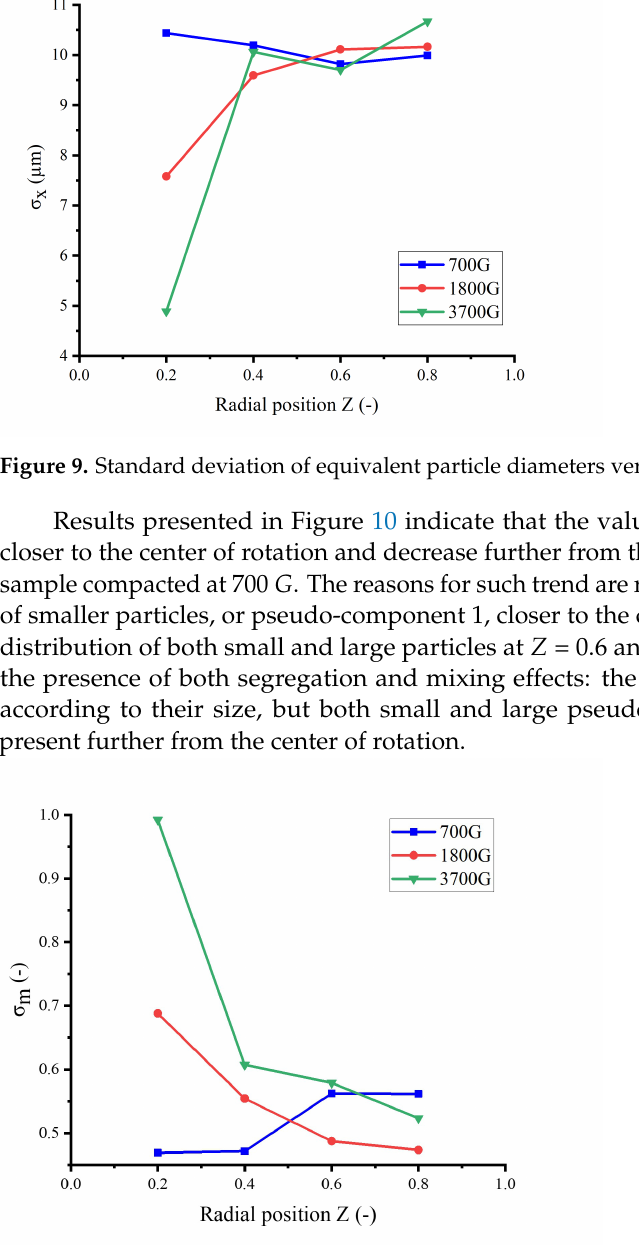
Figure 10. Standard deviation of particle concentrations versus radial